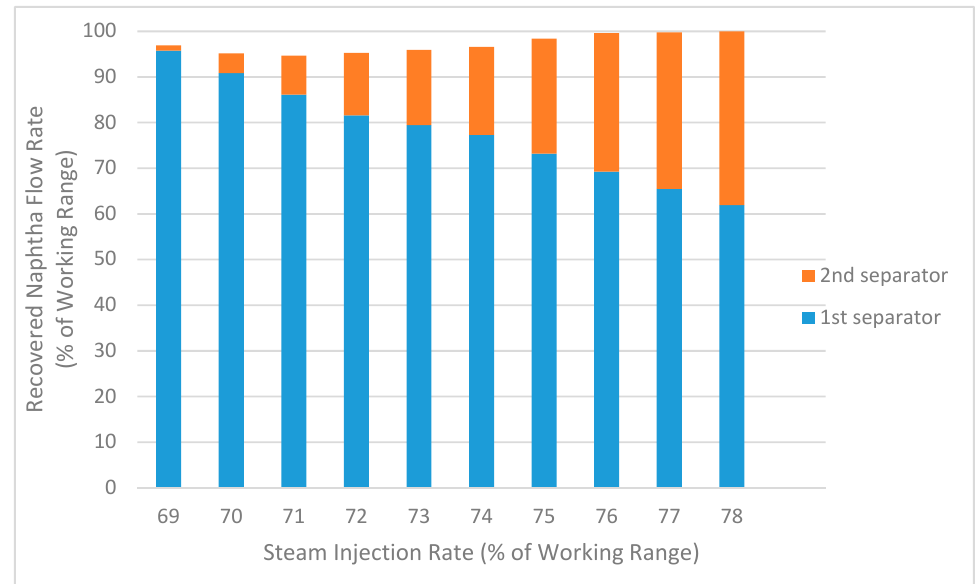
Figure 16. Impact of steam on recovered naphtha from separators 1 and 2 as predicted by Aspen Plus model.